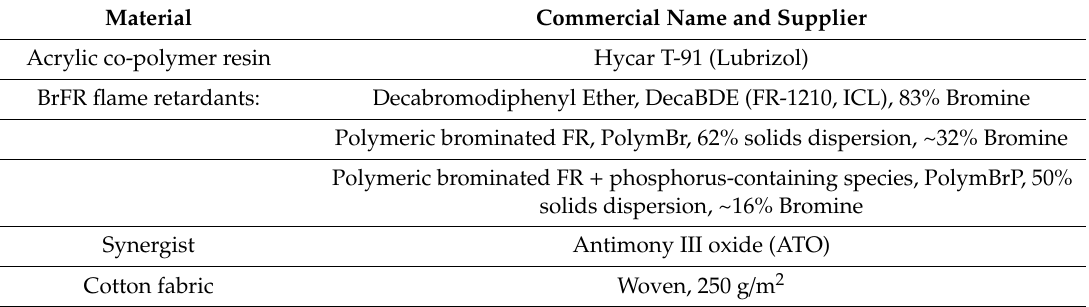
Table 1. Materials used for back-coating cotton with BrFR / ATO formulations